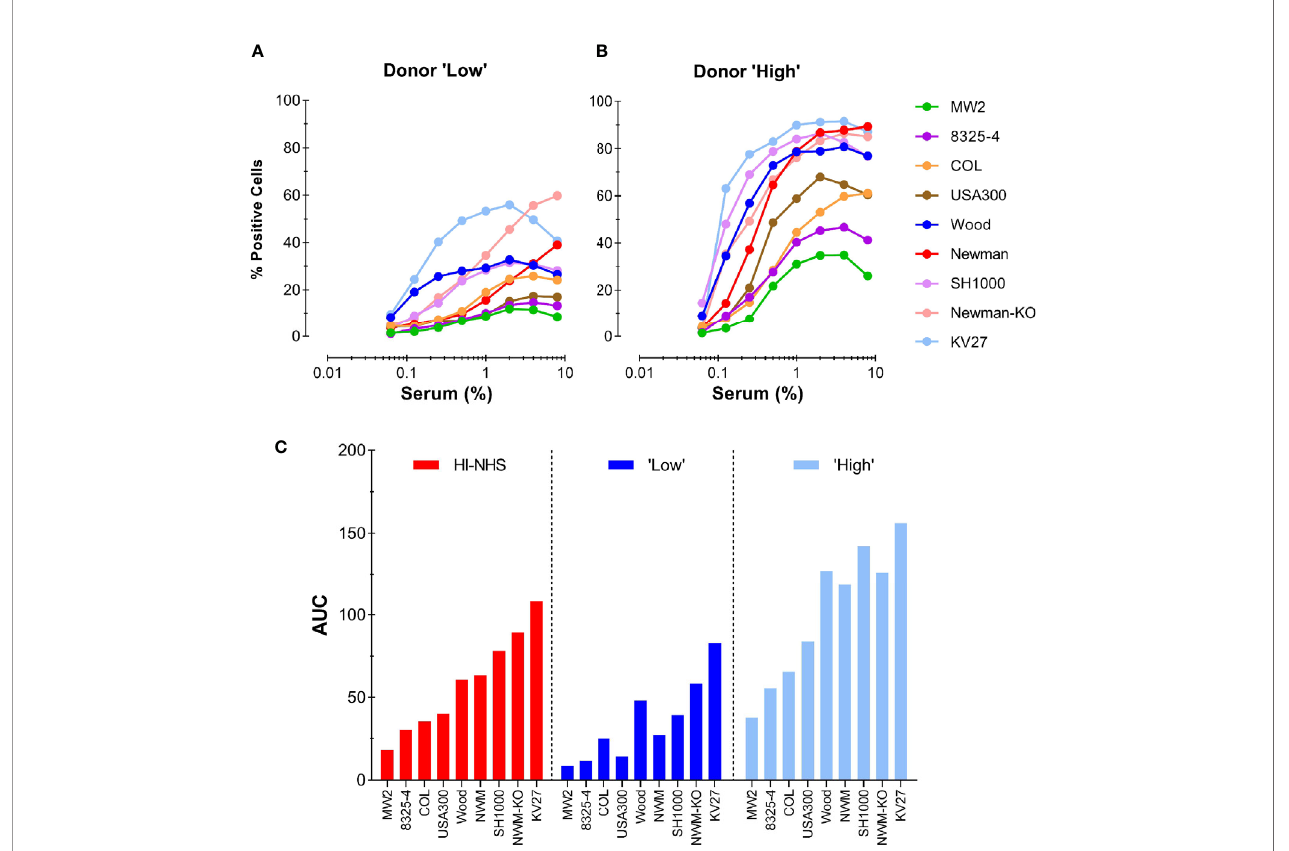
FIGURE 6 | Consistent donor opsonic capacity for multiple S. aureus strains. (A, B) Phagocytosis of different S. aureus strains opsonized with HI-serum of two individual donors chosen from the panel of 37 individual donors. Donor with “ Low ” (A) and donor with “ High ” (B) opsonic capacity as determined for Newman D SpA D Sbi were compared with HI-NHS (graph not shown). (C) AUC values for each individual S. aureus curve were ranked in ascending order for HI-NHS as opsonic source. Data are from one experiment using standard 10:1 bacteria to neutrophil ratio and 15 min phagocytosis time and expressed as % GFP+